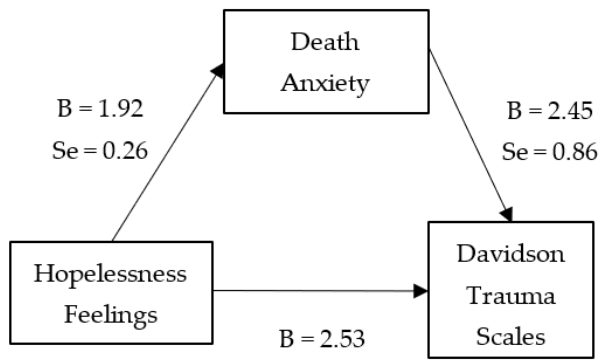
Figure 1. Mediation analysis between hopelessness and the development of post-traumatic symp- toms.